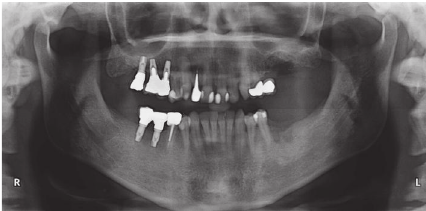
Figure 3: OPT recorded after sectioning the prosthesis and extracting the compromised element. The residual ridge presents a significant